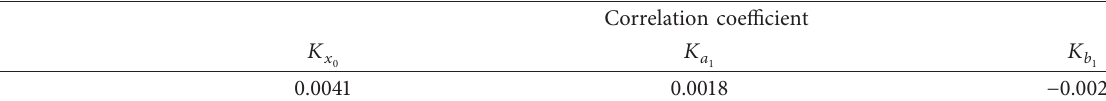
Figure 6: The correlation properties analysis. (a) Autocorrelation. (b) Cross-correlation. Table 6: Correlation coefficient of different initial